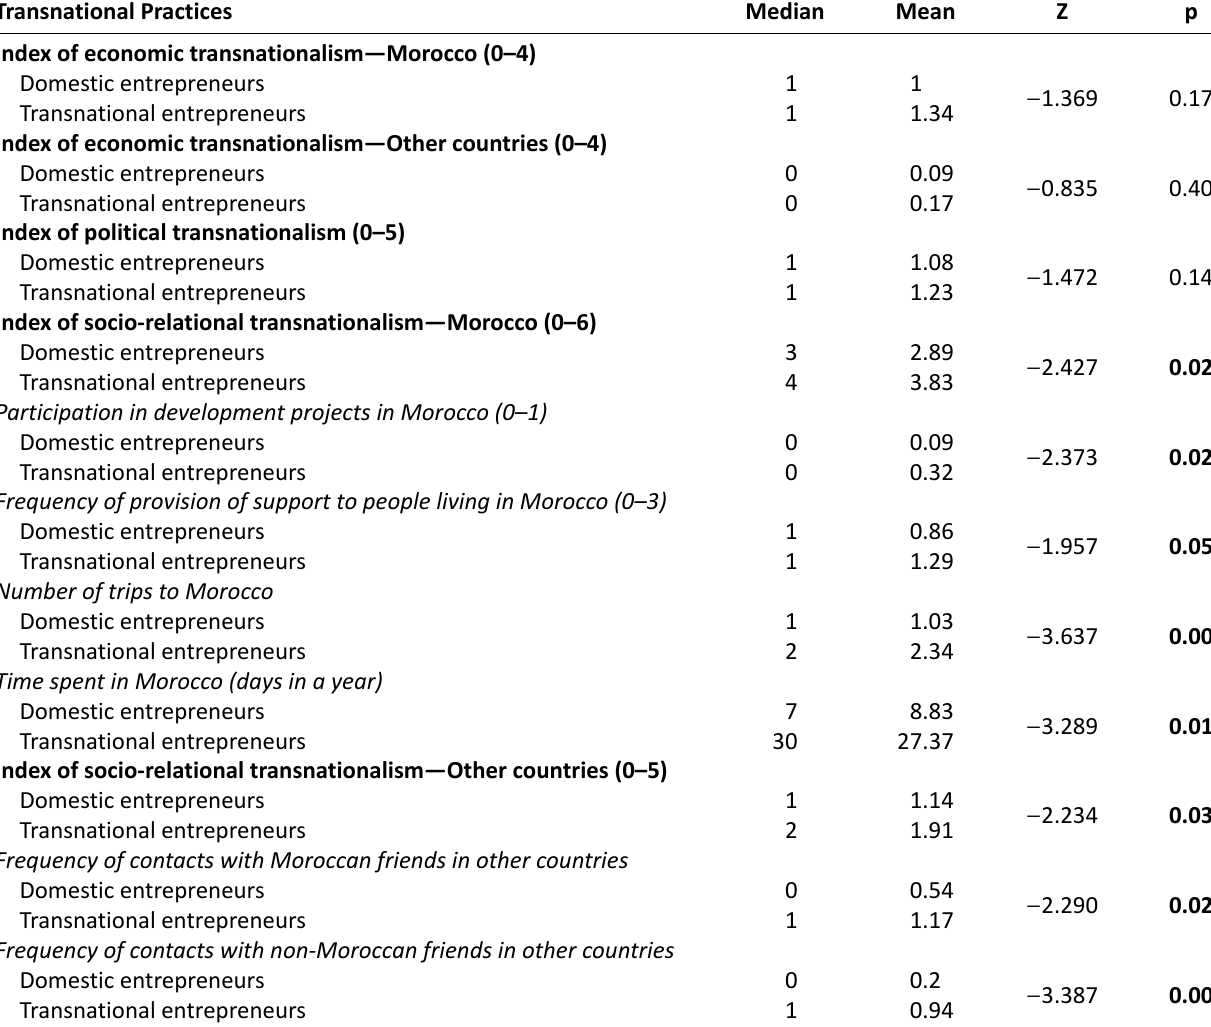
Table 1. Number of transnational practices by domains: transnational and domestic entrepreneurs. Transnational